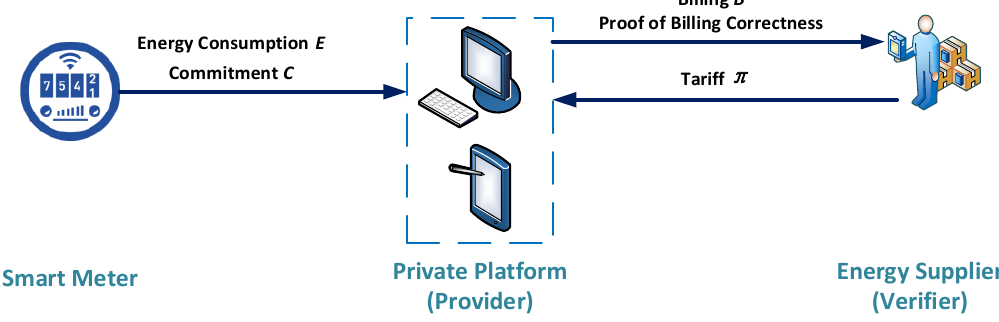
Figure 3. Time-of-use billing channel and billing correctness verification .